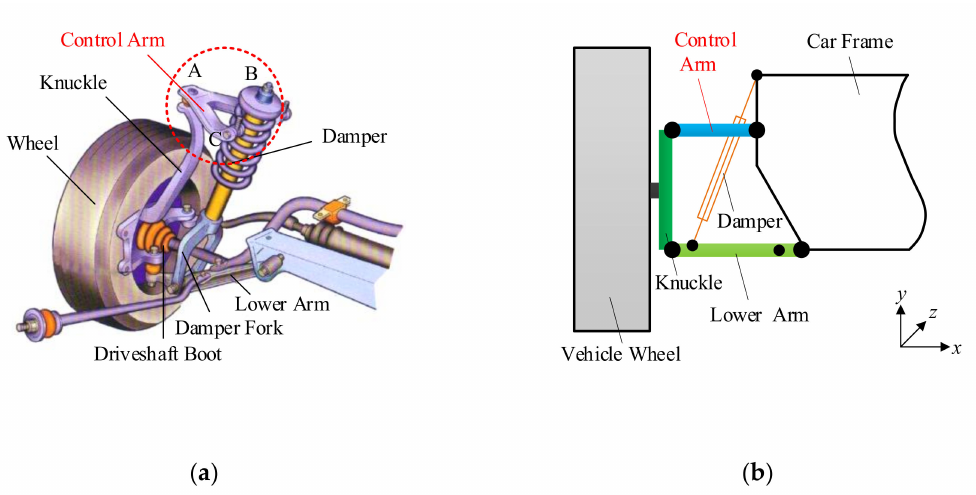
Figure 7. Suspension system diagram. ( a ) The schematic diagram of suspension system [38]; ( b ) the front view of the suspension system.